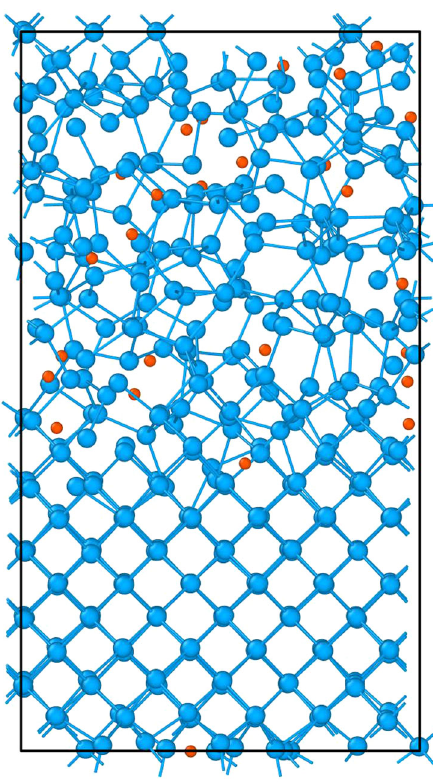
Fig. 9 c-Si/a-Si:H interface structure. Shown is a stick and ball model of one of the fi nal interface structures used in our study. The blue atoms represent silicon and the red atoms represent hydrogen.